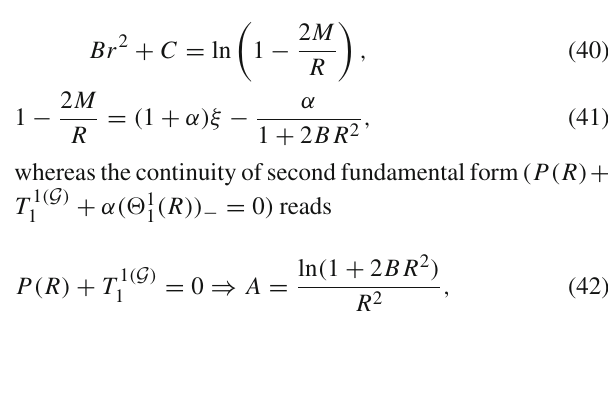
Fig. 1 Plots of ¯ ρ (left plot, row-1), ¯ P r (right plot, row-1), ¯ P t (left plot, row-2) and ¯ (cid:14) (right plot, row-2) against r using M 0 = 1 M (cid:9) and R = ( 0 . 2 ) − 1 M (cid:9) for